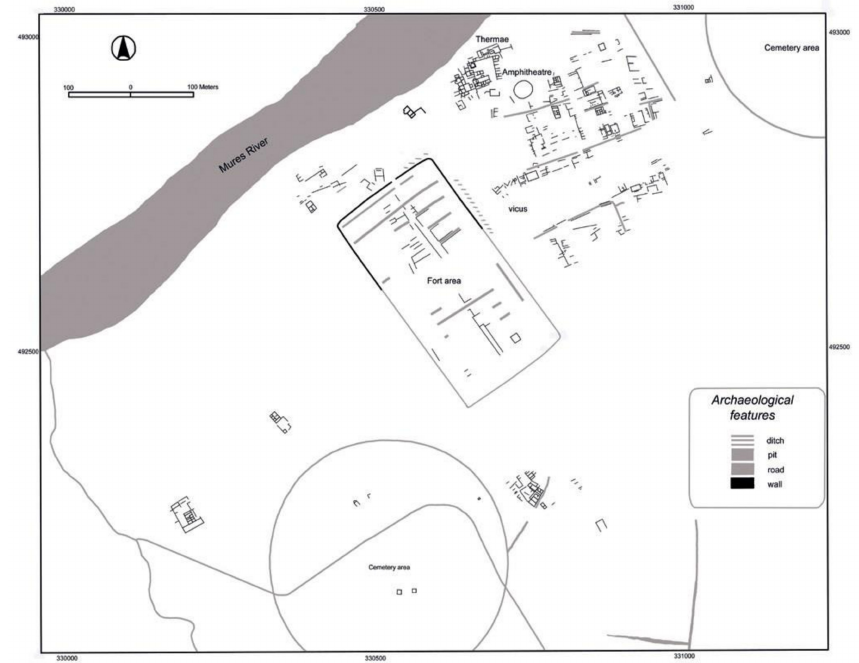
Figure 3. Micia archaeological site – drawing of the main archaeological features ( ©